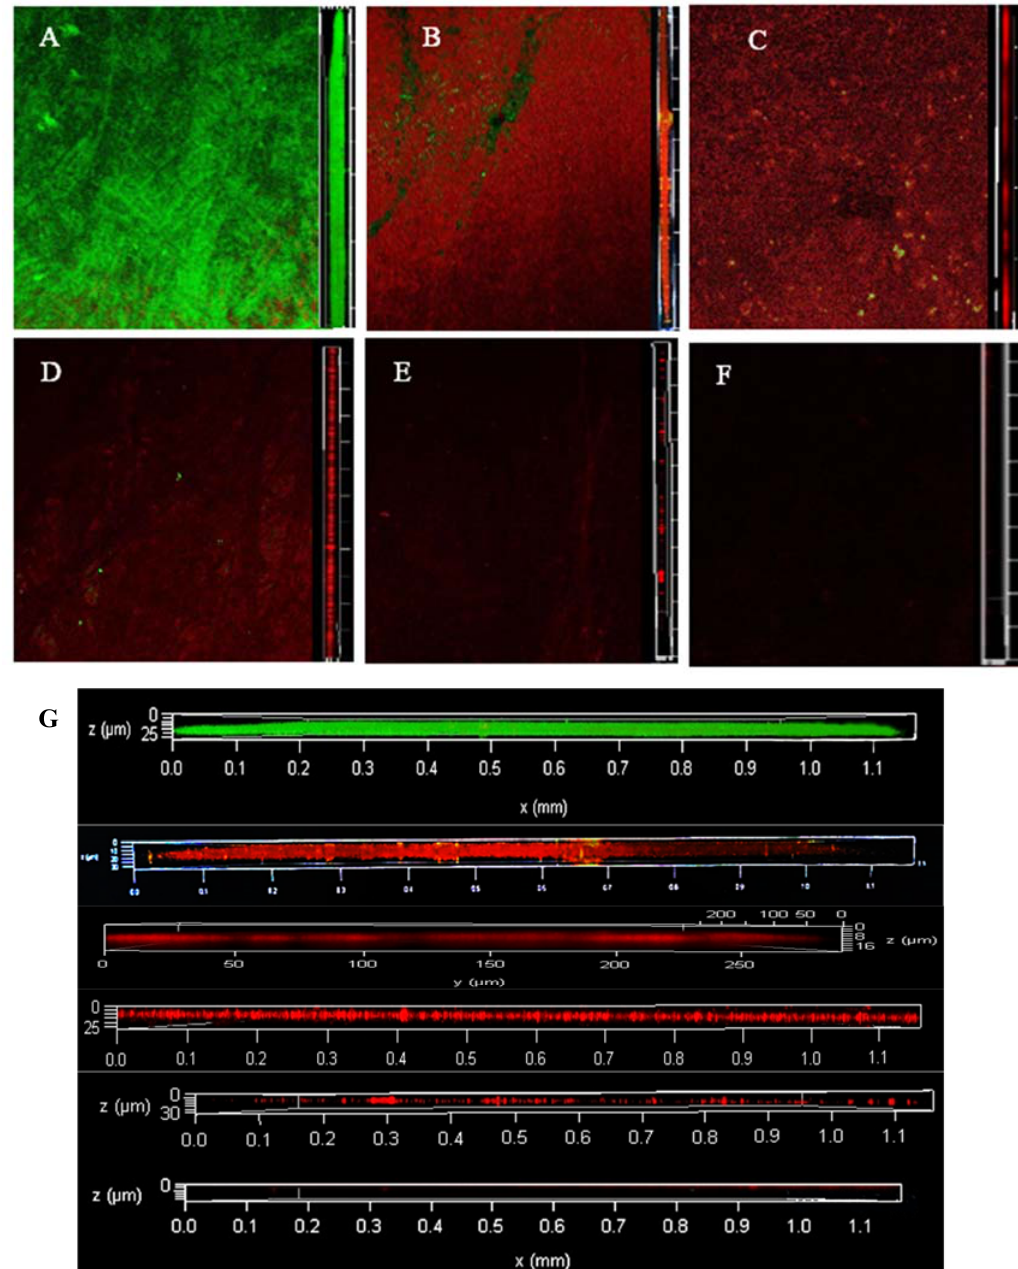
Figure 2. The changes of viable and dead colonies in LM biofilm after SAEW treatment observed by CLSM; each sample randomly selects three visual fields. Images include front and side views of the biofilm under CLSM. Scale bar—100 µ m. ( A – F ) represent the dead or alive status of the remaining bacteria after 0, 2, 4, 6, 8 and 10 min of treatment, respectively. ( G ) is an enlarged version of all the images on the right and is also a right-hand view of the biofilm, from top to bottom, for SAEW treatments 0, 2, 4, 6, 8 and 10 min respectively. SAEW was the abbreviation of slightly acidic electrolytic water. Green—live cells, red—dead cells.